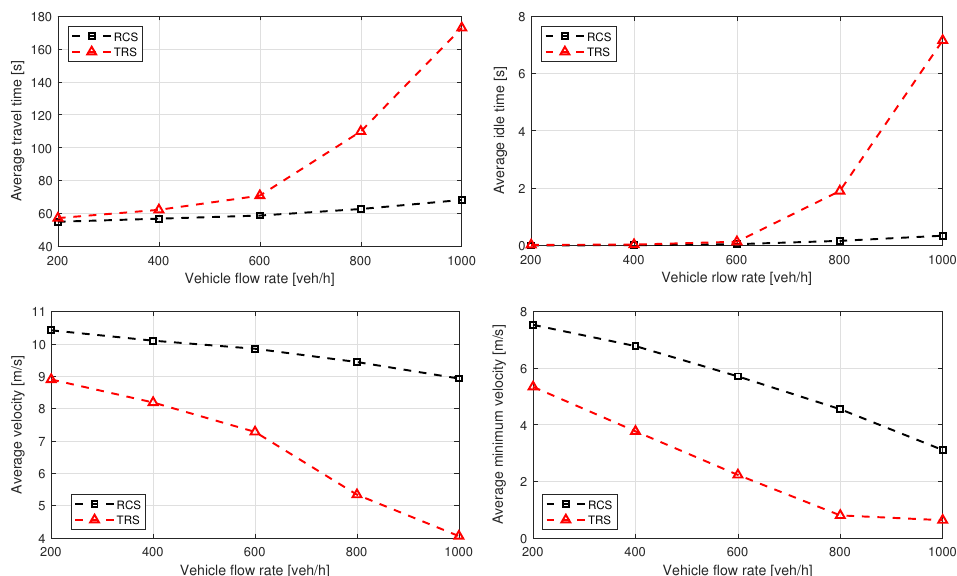
Figure 6. Case 1 performance comparison of roundabout control system (RCS) proposed in this paper and traditional roundabout system (TRS). Each entry lane has the same traffic flow rates and the entry flow rates are equal to the circulating flow rates. The sub-figures show improvements in average traveling time, average idling time, average velocity, and average minimum velocity for the balanced traffic flow.